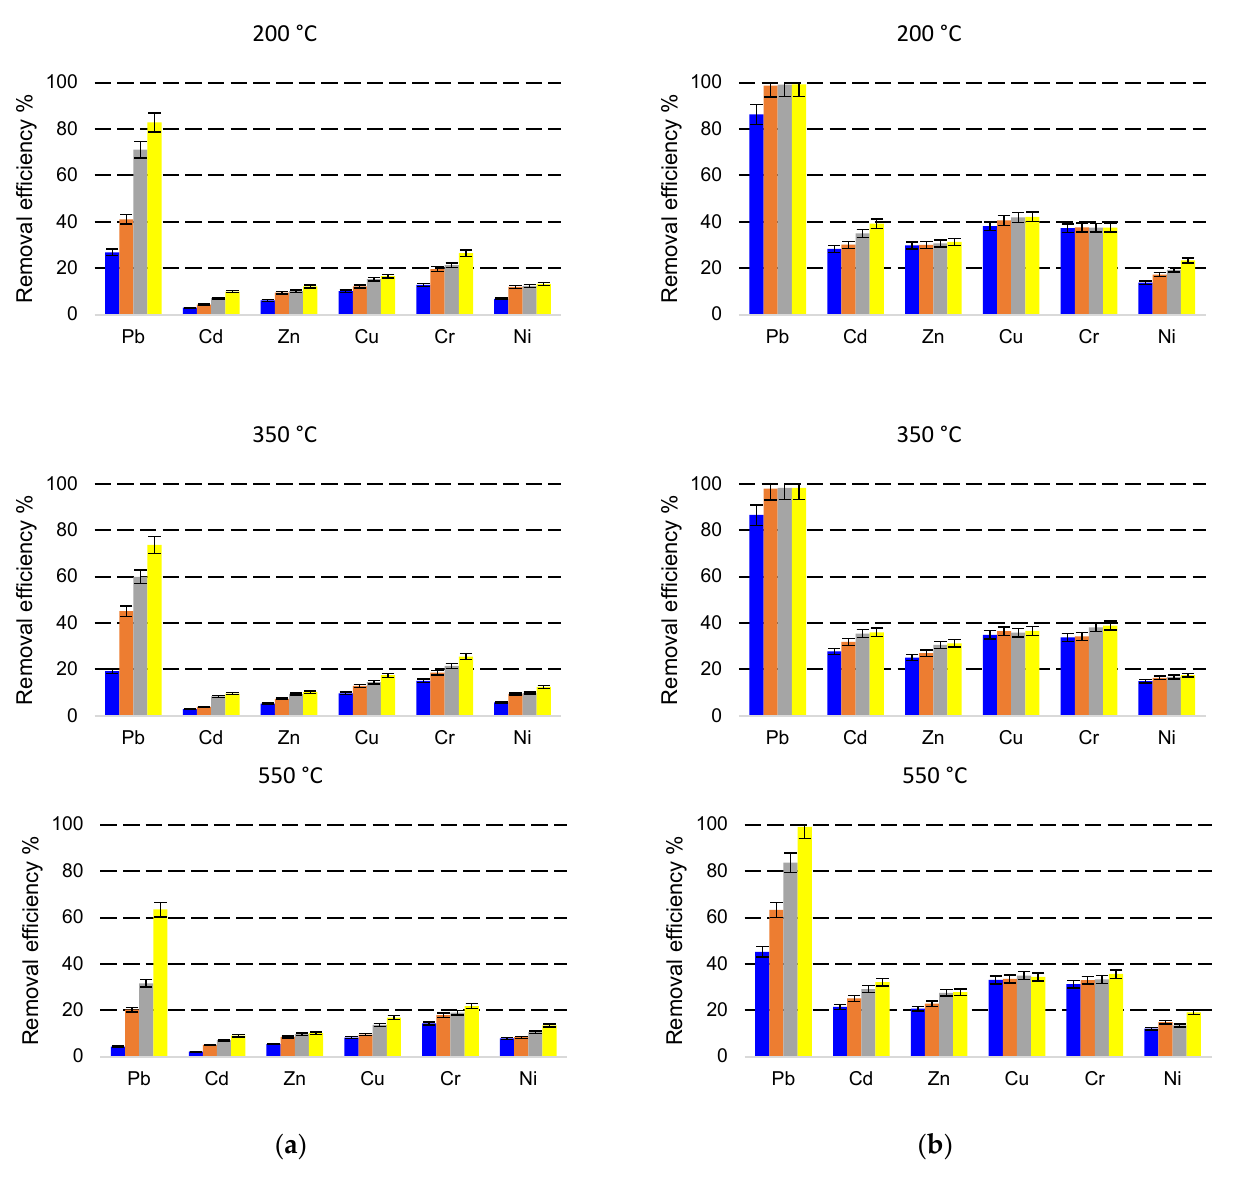
Figure 4. Simultaneous removal of Pb, Cd, Zn, Cu, Cr, Ni with NZ1 ( a ) and NZ2 ( b ) thermally treated at 200 °C, 350 °C, and 550 °C from a multicomponent solution of 30 mg L − 1 at four different contact times (5 min—blue, 10 min—orange, 30 min—grey, 60 min—yellow).